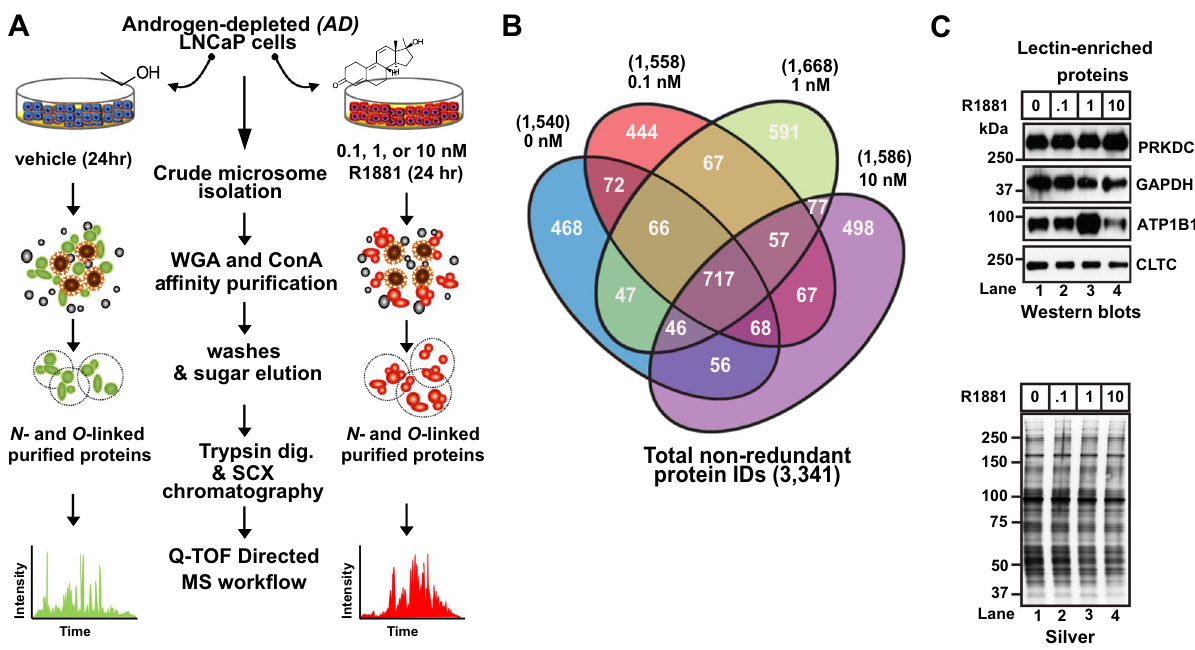
Figure 1. Quantitative mass spectrometry profiling of membrane-associated glycoproteins in LNCaP cells. ( A ) Experimental workflow for the proteomic profiling of N -linked and O -linked glycosylated membrane proteins expressed in LNCaP following exposure to androgen-depleted ( AD ) and androgen-stimulated ( AS ) ( i.e. , 0.1 nM, 1 nM, or 10 nM R1881) growth medium. ( B ) Summary of protein quantification analysis. Venn diagram illustrating quantities of proteins shared among and unique to vehicle ( i.e. , EtOH) and androgen- treated ( i.e. , 0.1, 1, and 10 nM R1881) samples. A total of 3,341 non-redundant proteins were identified as being differentially expressed, and they were quantified across all samples. ( C ) Semi-quantitative western-blot showing expression of DNA-dependent protein kinase catalytic subunit (PRKDC), glyceraldehyde 3-phosphate dehydrogenase (GAPDH), sodium and potassium ATPase (Na + /K + ATPase), and clathrin heavy chain 1 (CLTC) in glycoprotein-enriched extracts. (Lower panel) Silver-stain gel showing loading of glycoprotein- enriched samples.